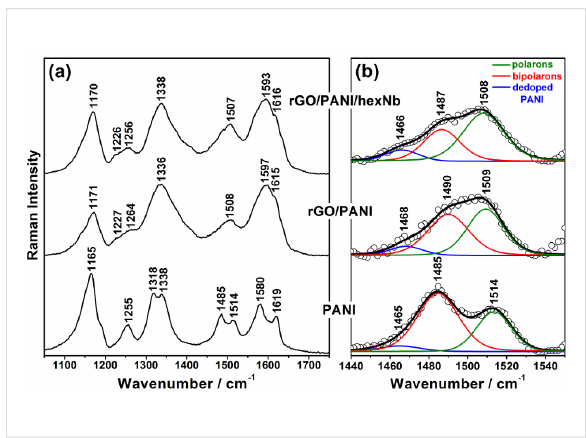
the ternary nanocomposite (polaron/bipolaron = 3.0), compared to PANI (2.6) and the binary nanocomposite (2.7). This indi-